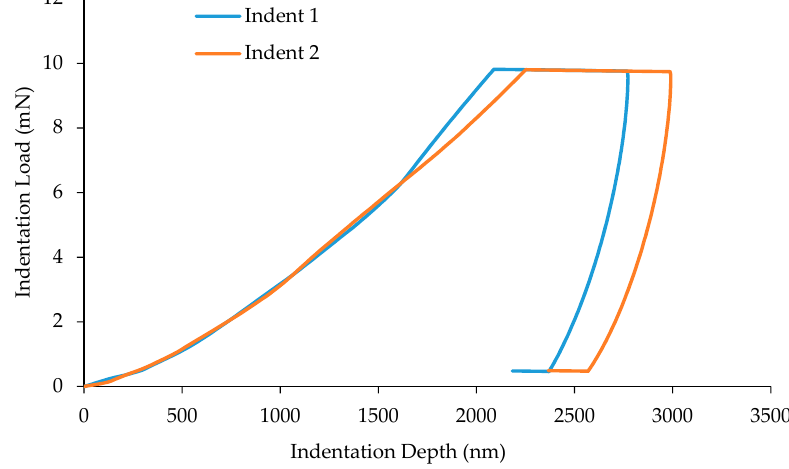
Figure 3. Load-displacement curve for two separate indents on mastic phase.